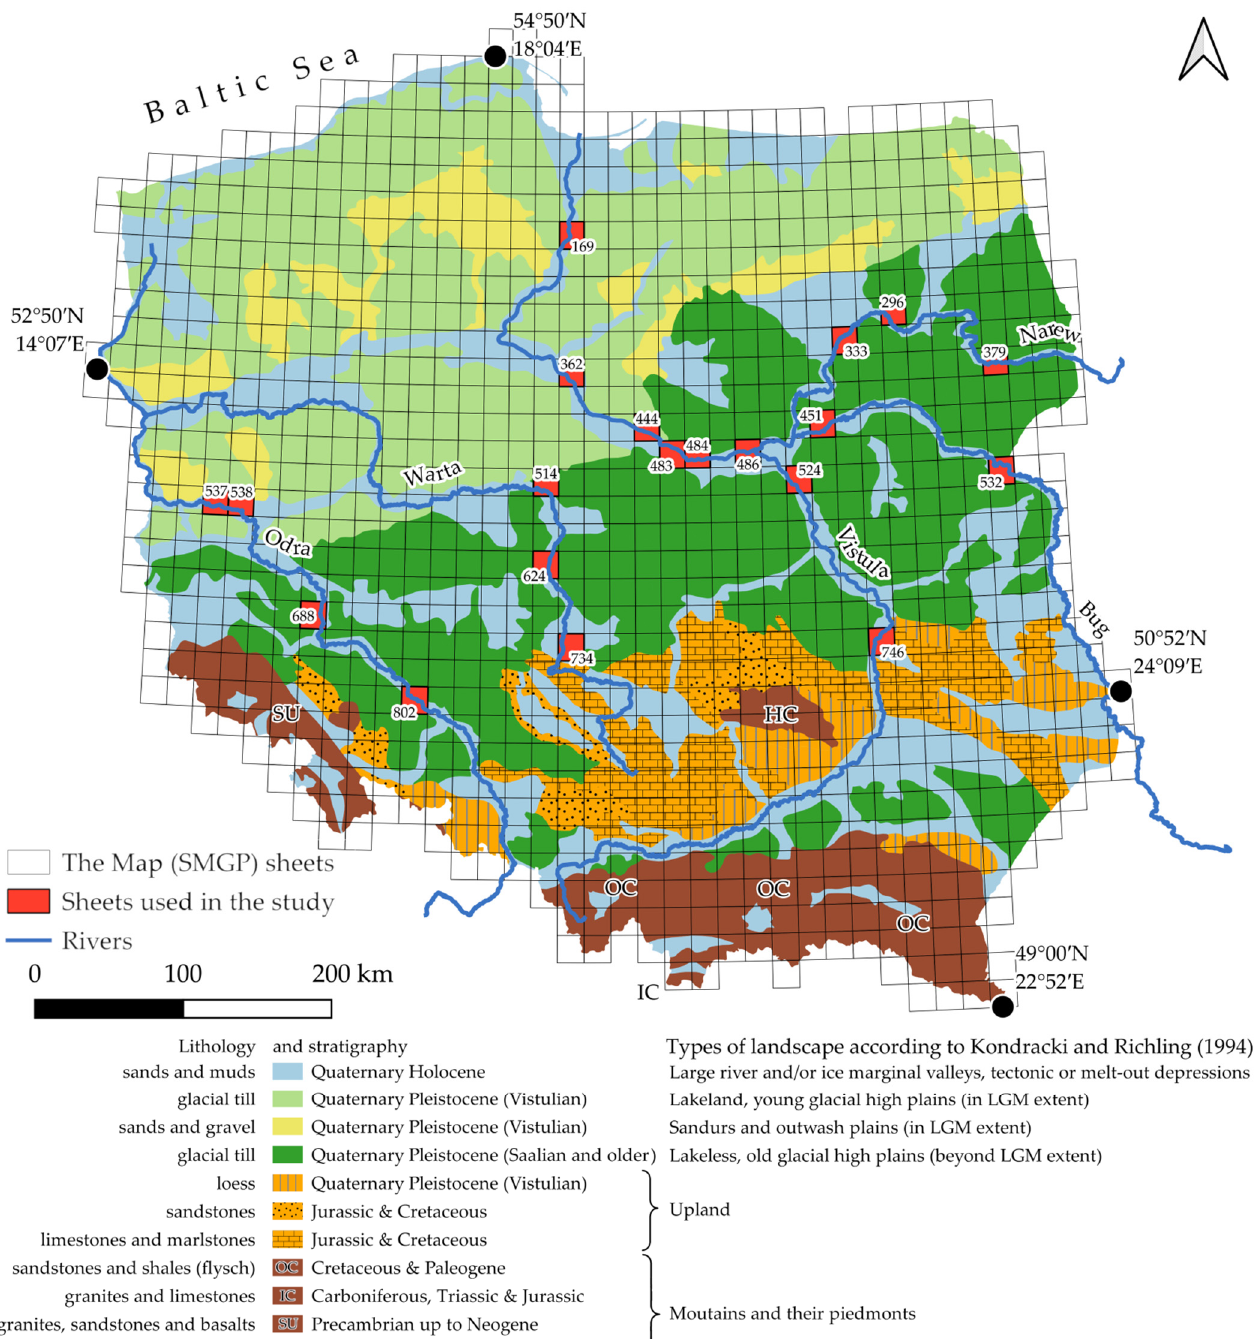
Figure 1. Physical map of Poland, Kondracki and Richling [46], with five the largest Polish rivers (Odra, Warta, Vistula, Bug, and Narew) and 1069 sheets of the Map (Detailed Geological Map of Poland, in Polish: SMGP), among them 20 sheets used in the study. LGM—Last Glacial Maximum, OC—Outer Carpathians Mts., IC—Inner Carpathian Mts., SU—Sudetes, HC—Holy Cross Mts.